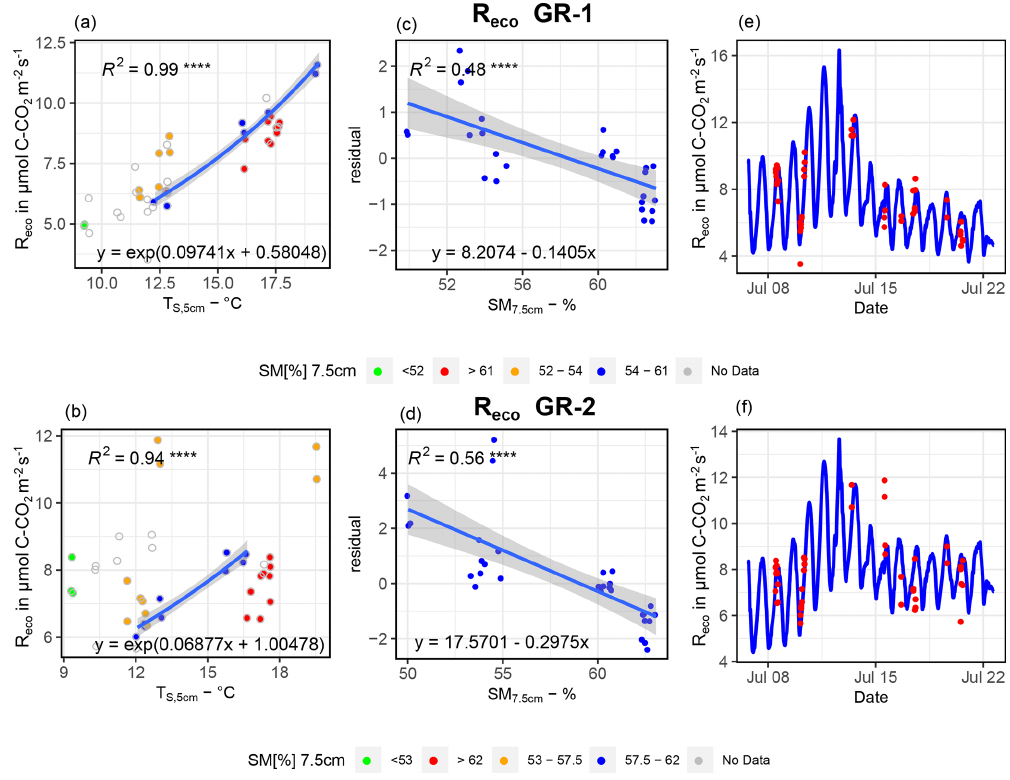
Figure B1. Depiction of the relationship between T S, 5cm and SM and R eco for GR-1 (a, c, e) and GR-2 (b, d, f) . Interpolation models are formed by the equations of depicted regression curves. The graphs on the right (e, f) show modeled vs. measured fluxes.